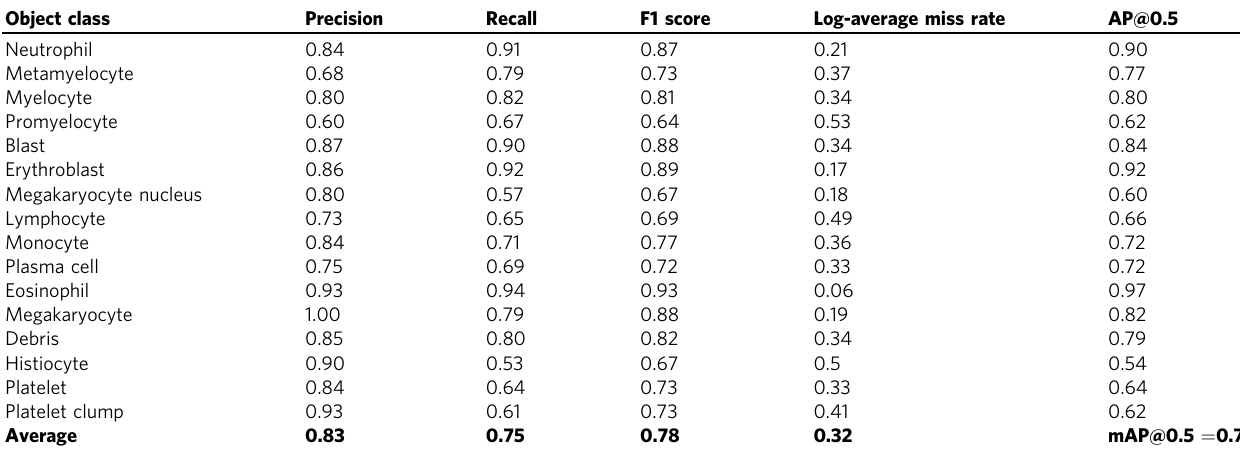
Table 3 Performance result of the proposed cell detection and classi fi cation model. Object class Precision Recall F1 score Log-average miss rate AP@0.5